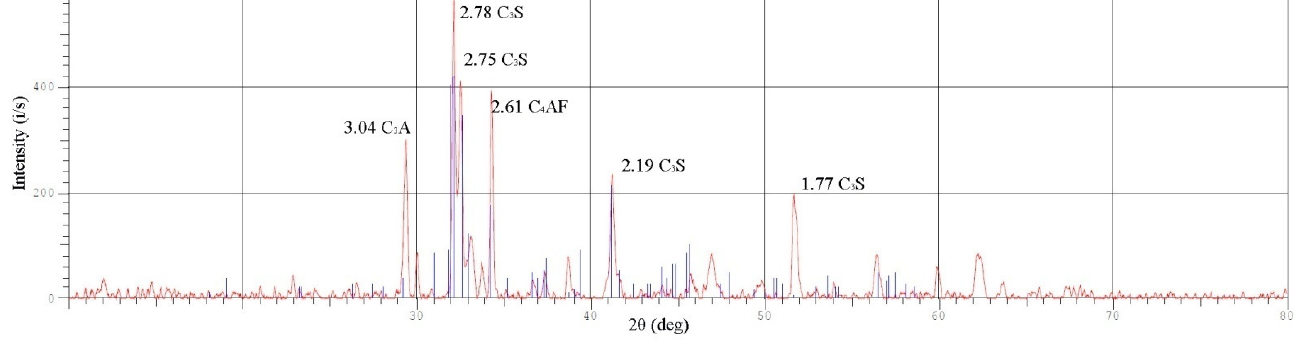
Figure 5. X-ray diffraction pattern of the minerals of the obtained coagulant. Table 3. Mineral composition of the calcium–aluminum–silicate reagent.